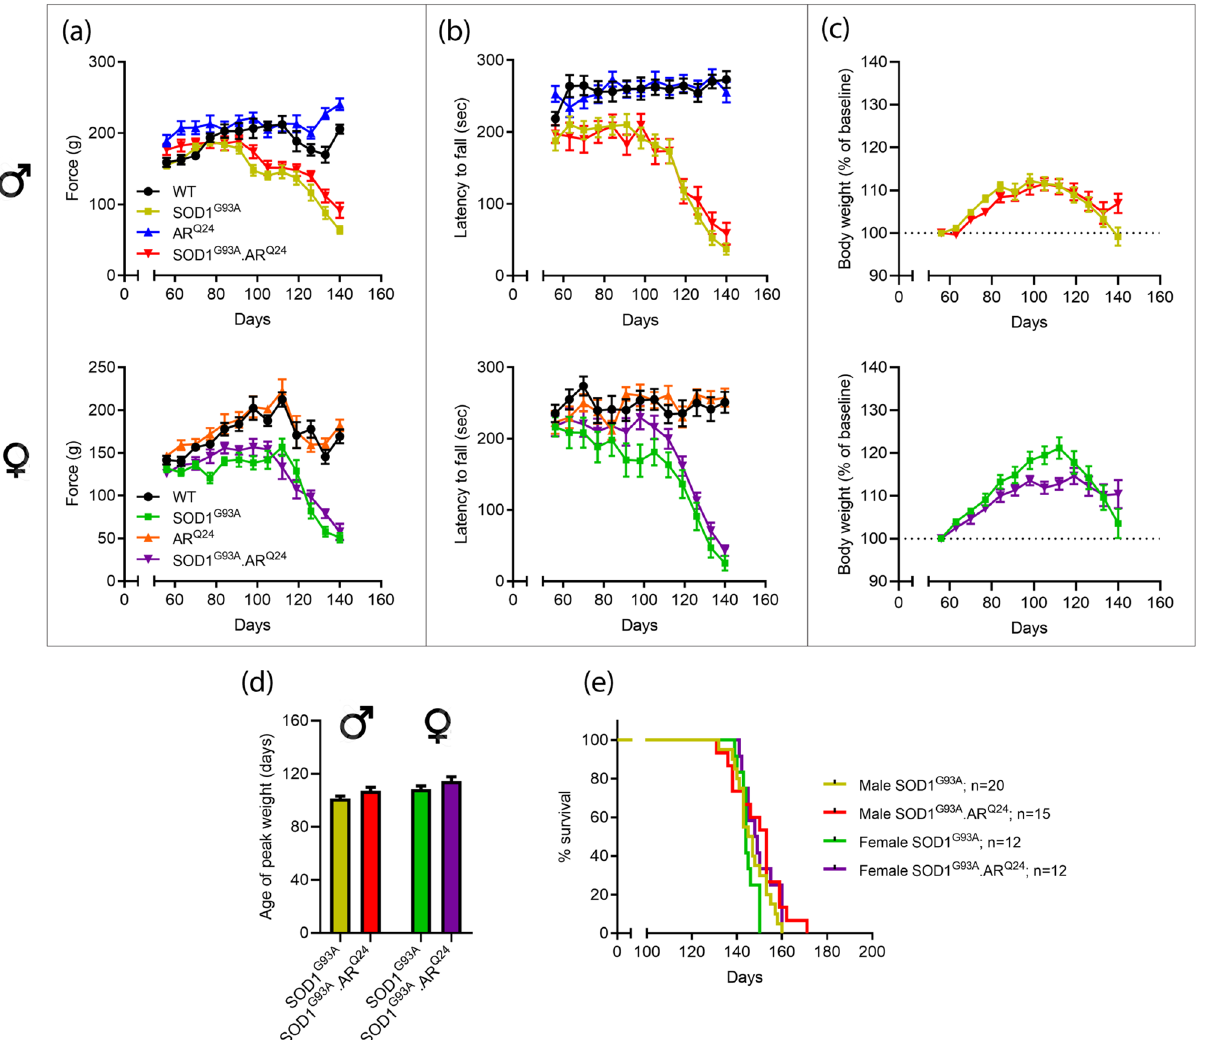
Figure 4. Global overexpression of AR does not influence disease progression and survival in SOD1 G93A mice. Motor function assessment by (a) four limb grip strength and (b) rotarod performance and (c) body weight analysis of AR Q24 x SOD1 G93A cross male and female mice over disease course. (d) Age in weeks when peak weight occurred in males and female. (e) Kaplan–Meier curves showing comparable survival in SOD1 G93A :AR Q24 mice compared to SOD1 G93A mice. All values presented as mean ± SEM; n = 12–20 mice per evaluated in SOD1 G93A mice. SOD1 G93A mice were crossed with AR Q24 mice, giving rise to WT, SOD1 G93A , AR Q24 and SOD1 G93A :AR Q24 genotypes. Muscle strength showed comparable decline in SOD1 G93A and SOD1 G93A :AR Q24 mice with consistent performance maintained in aged-matched non-disease counterparts, AR Q24 and WT mice (Fig. 4a). In SOD1 G93A male mice, the onset of decline in grip strength was 89 ± 9 days compared to 103 ± 12 days in female mice (P = 0.0006 by unpaired t-test, Fig S4a). AR overexpression did not have a significant effect on the onset of decline in grip strength in SOD1 G93A mice, with onset occurring at 95 ± 10 days and 102 ± 11 days in SOD1 G93A :AR Q24 male and female mice, respectively. Similar trends were observed in locomotor performance (Fig. 4b) with the onset of decline in function occurring at 102 ± 10 days compared to 110 ± 7 days in male and female SOD1 G93A mice, respectively (P = 0.0221 by unpaired t-test, Fig S4b). Again, AR overexpression did not have an effect on disease onset determined by locomotor performance, occurring at 107 ± 9 days and 106 ± 9 days in SOD1 G93A :AR Q24 male and female mice, respectively. Comparable weight declines were apparent between SOD1 G93A and SOD1 G93A :AR Q24 genotypes (Fig. 4c). Age of peak body weight showed a significant effect of sex (F (1,56) = 7.82; P = 0.0071) and genotype (F (1,56) = 5.24; P = 0.0258) on disease onset when analysed by two-way ANOVA (Fig. 4d). Multiple comparisons did not reveal significant intergroup differences. Separate analysis of male vs. female SOD1 G93A mice again revealed males had a significantly earlier disease onset compared to female mice (P = 0.0271 by unpaired t-test, Fig S4c), showing a consistent trend across multiple methods of determin- ing disease onset in SOD1 G93A mice. The median lifespan of male SOD1 G93A mice (146 days) was comparable to SOD1 G93A :AR Q24 mice (153 days) ( P = 0.1494). Likewise, in females, no survival differences were apparent, with median survival of 144 vs. 149 days for SOD1 G93A and SOD1 G93A :AR Q24 mice, respectively ( P = 0.0810; Fig. 4e).